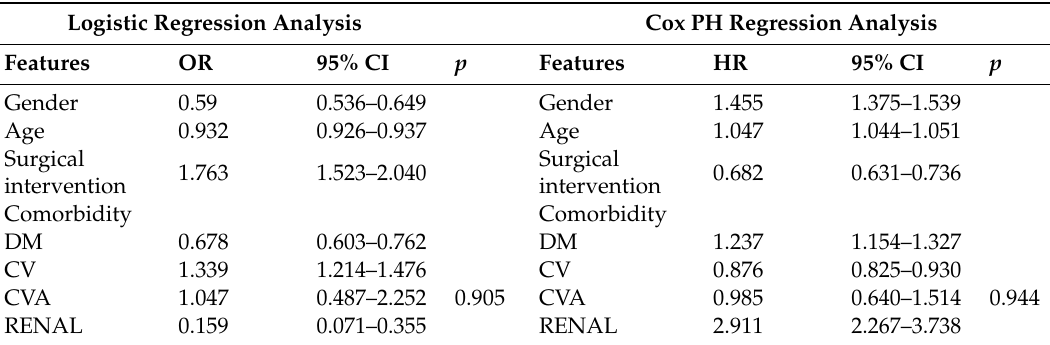
Table 5. Summary of mortality perdition